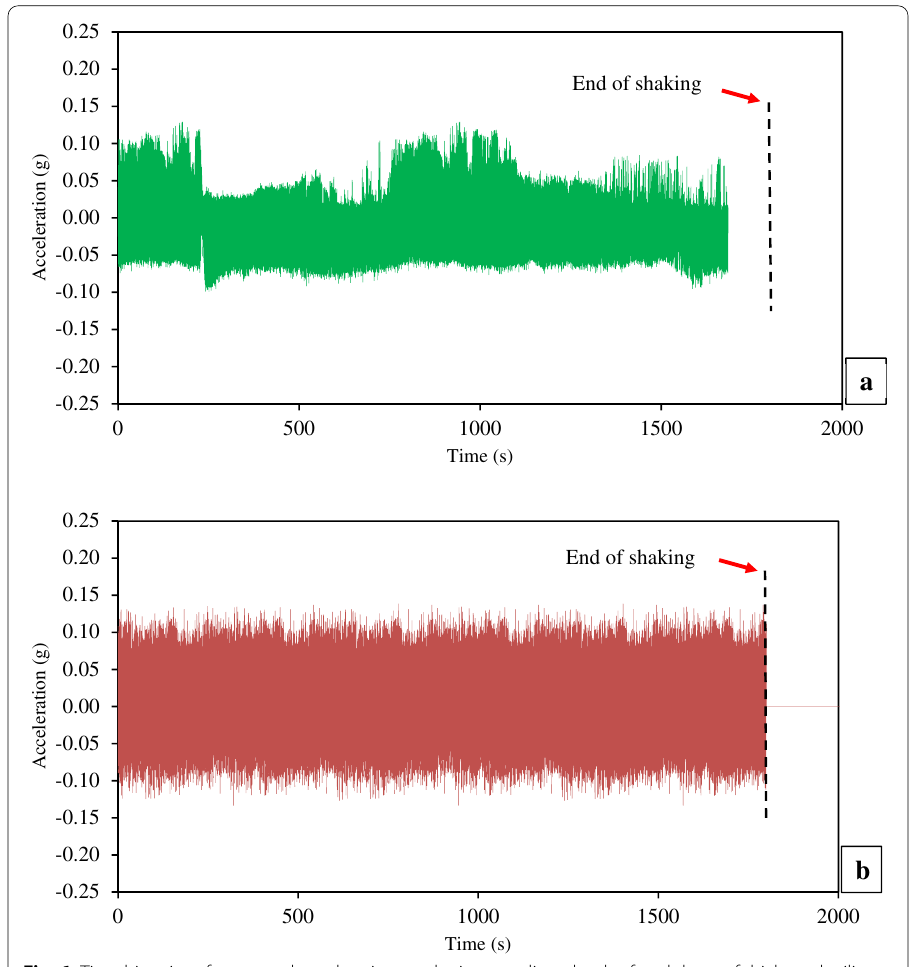
Fig. 6 Time histories of measured accelerations at the intermediate depth of each layer of thickened tailings deposit and at the base of the shaking table during shaking: a Layer 3 (top), b Layer 2 (middle), c Layer 1 (bottom), d shaking